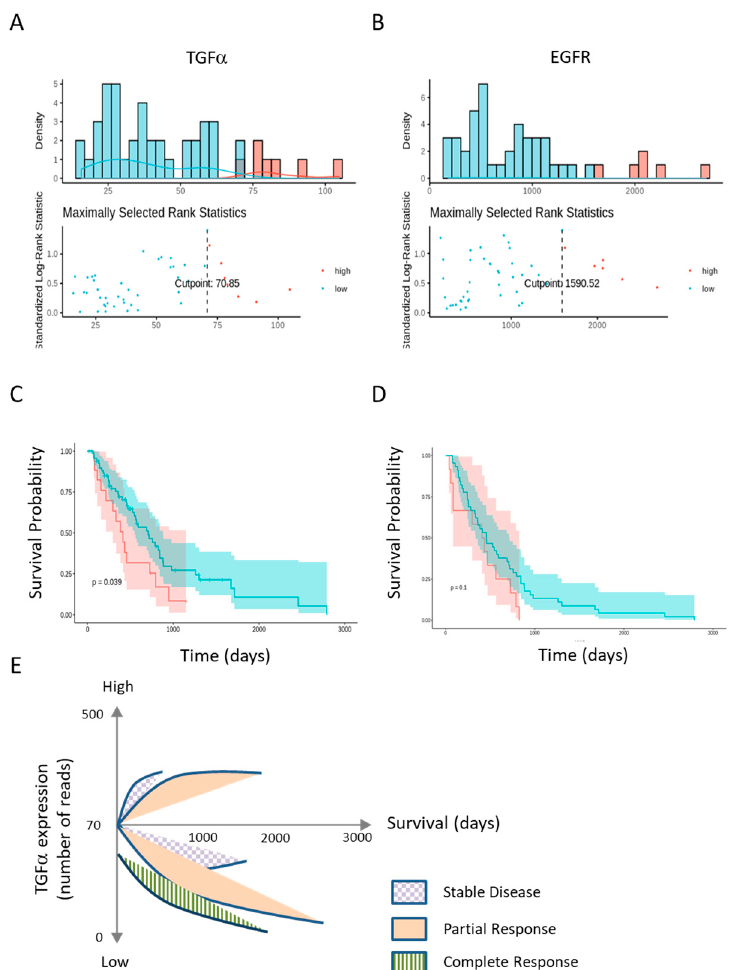
Figure 5. Kaplan-Meier survival curves of patients classified according to TGF α and EGFR expression. TGF α and EGFR expression datasets were downloaded from The Cancer Genome Atlas (TCGA). ( A ) and ( B ) Optimal cutpoints between high and low expression levels were calculated by maxstat for TGF α and EGFR, respectively; ( C ) and ( D ) Kaplan-Meier survival graphs were generated for patients categorized according to TGF α and EGFR expression; ( E ) Correlation of therapeutic response with survival of patients characterized by low and high TGF α expression.